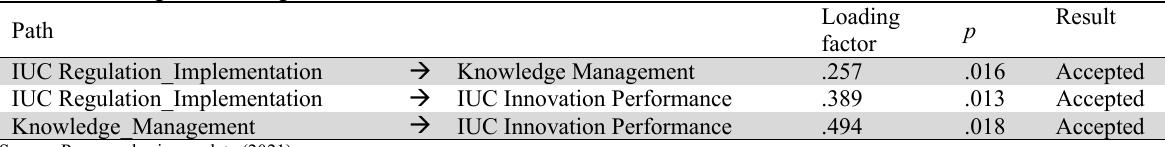
Standardized Regression